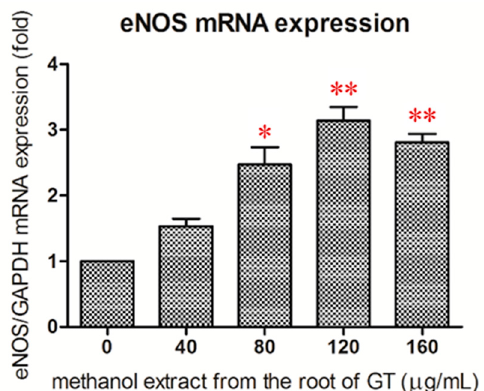
Figure 4. Effect of R/M GTE on eNOS mRNA expression in HUVECs. HUVECs were treated with R/M extract for 24 h. Real-time RT–PCR analysis was performed in order to analyze the expression level of mRNA of eNOS. Data were obtained from triplicate experiments, and are expressed as mean ± standard deviation. A significant difference from the vehicle was indicated as * p < 0.05 or ** p < 0.01 (Student’s t -test).